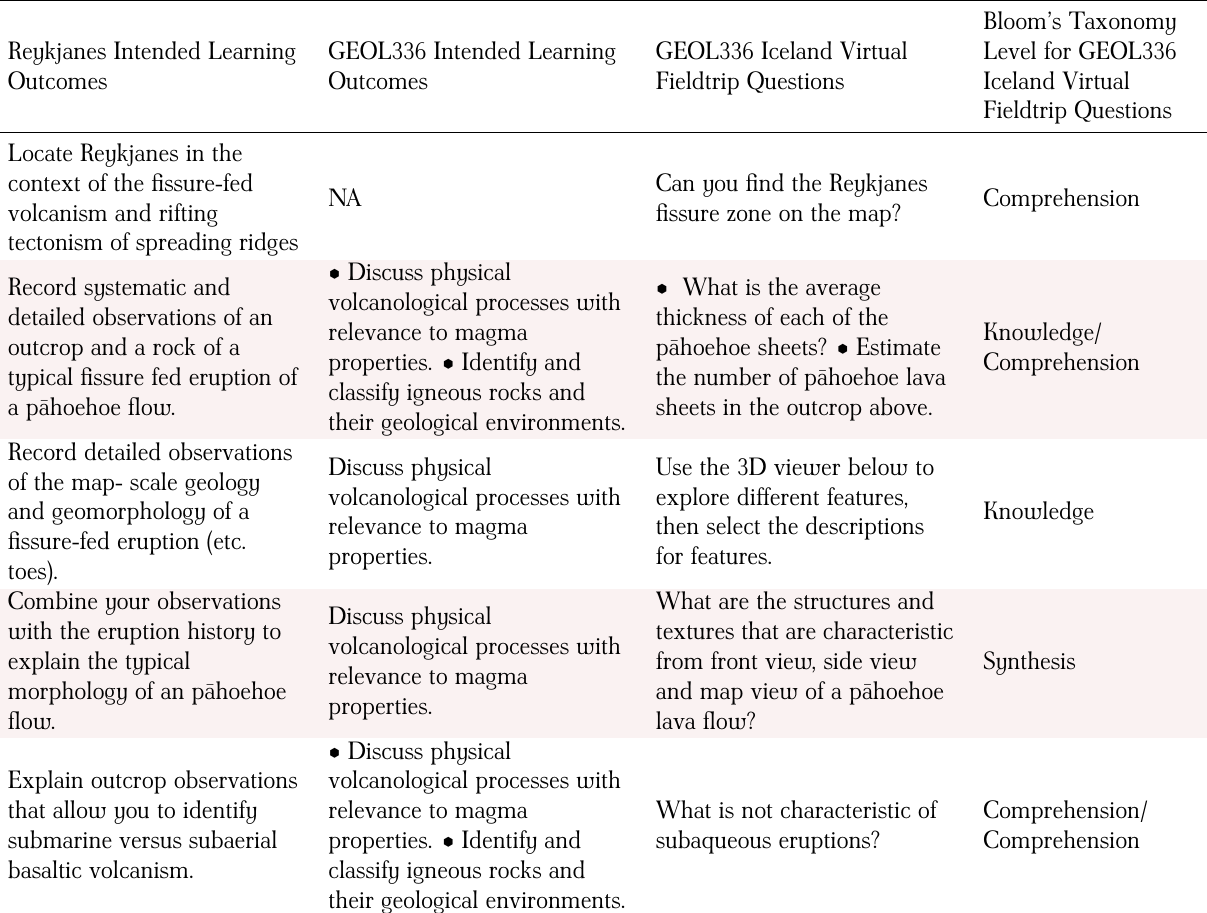
Table A1: Alignment of the VTF Reykjanes intended learning outcomes, the intended learning outcomes from the third-year undergraduate volcanology and magmatic systems course, and the associated Bloom’s taxonomy